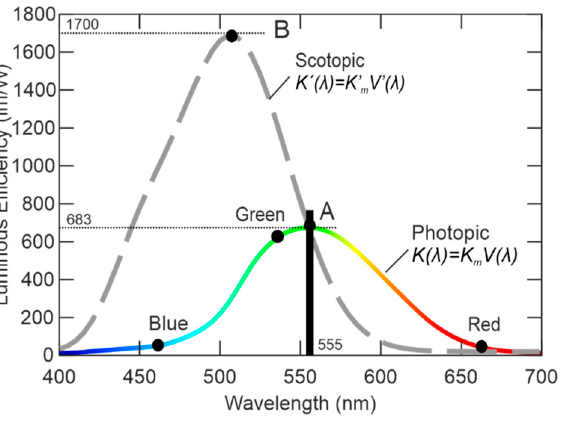
Figure 1. Sensoric characteristic of human eyesight (scotopic and photopic vision) (adapted from